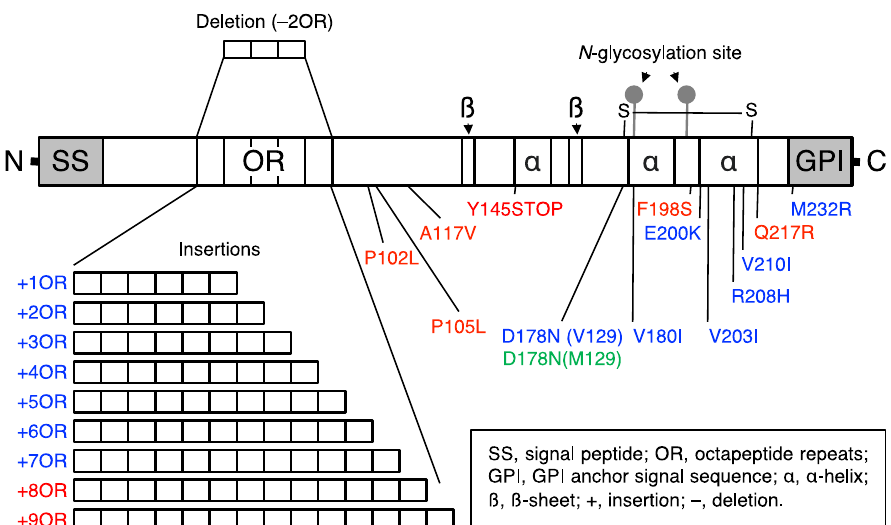
Figure 2. Schematic illustration of hereditary prion disease-associated mutations in PrP. GSS, fCJD, and FFI mutations are indicated in red, blue, and green, respectively.